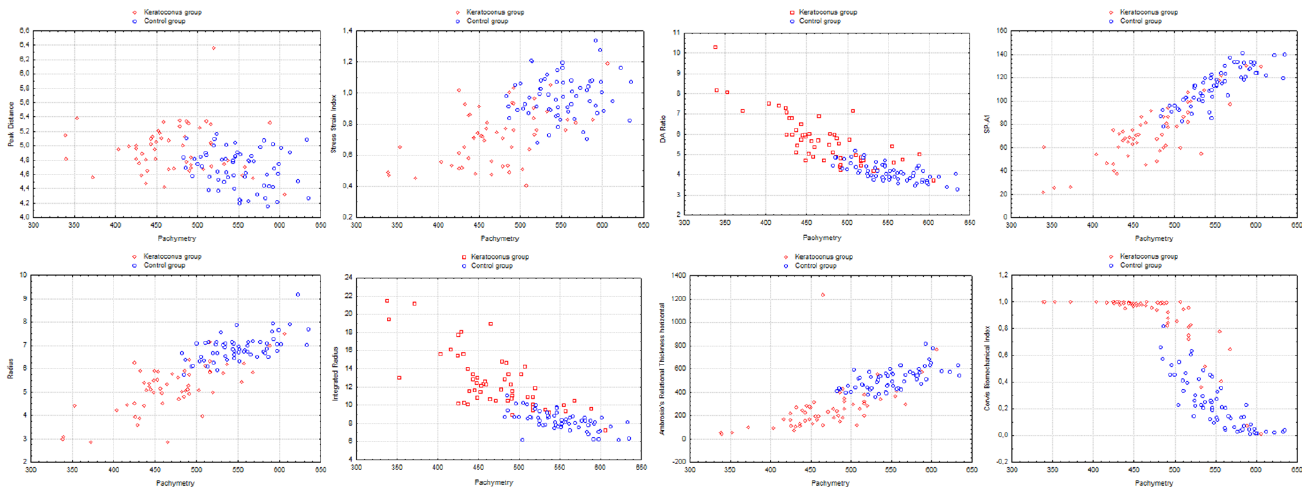
Figure 3. Scatterplots of the most relevant Corvis ST indices as a function of Pachymetry in both groups.